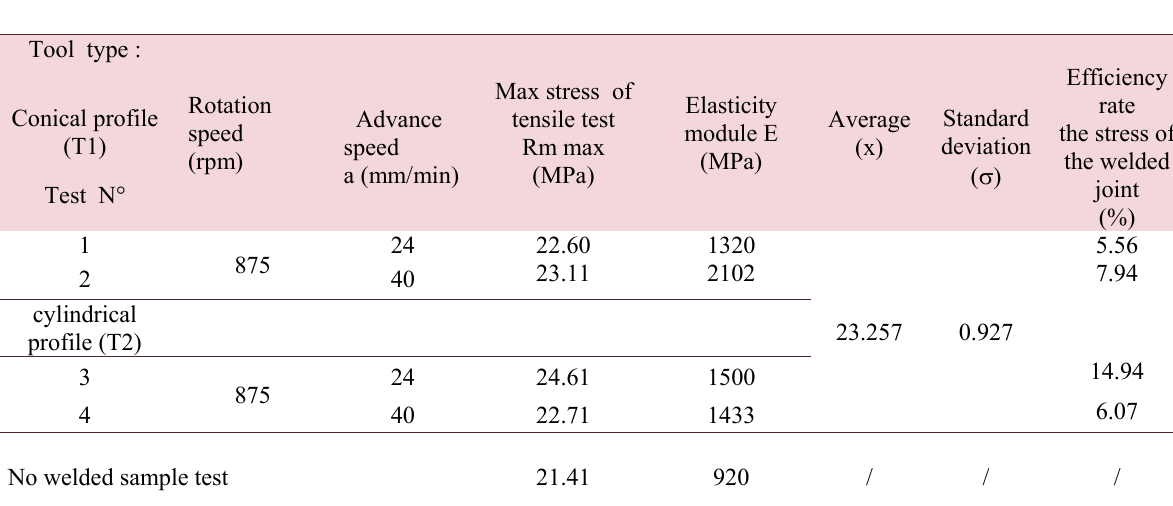
Figure 7: Law behavior of welded specimens